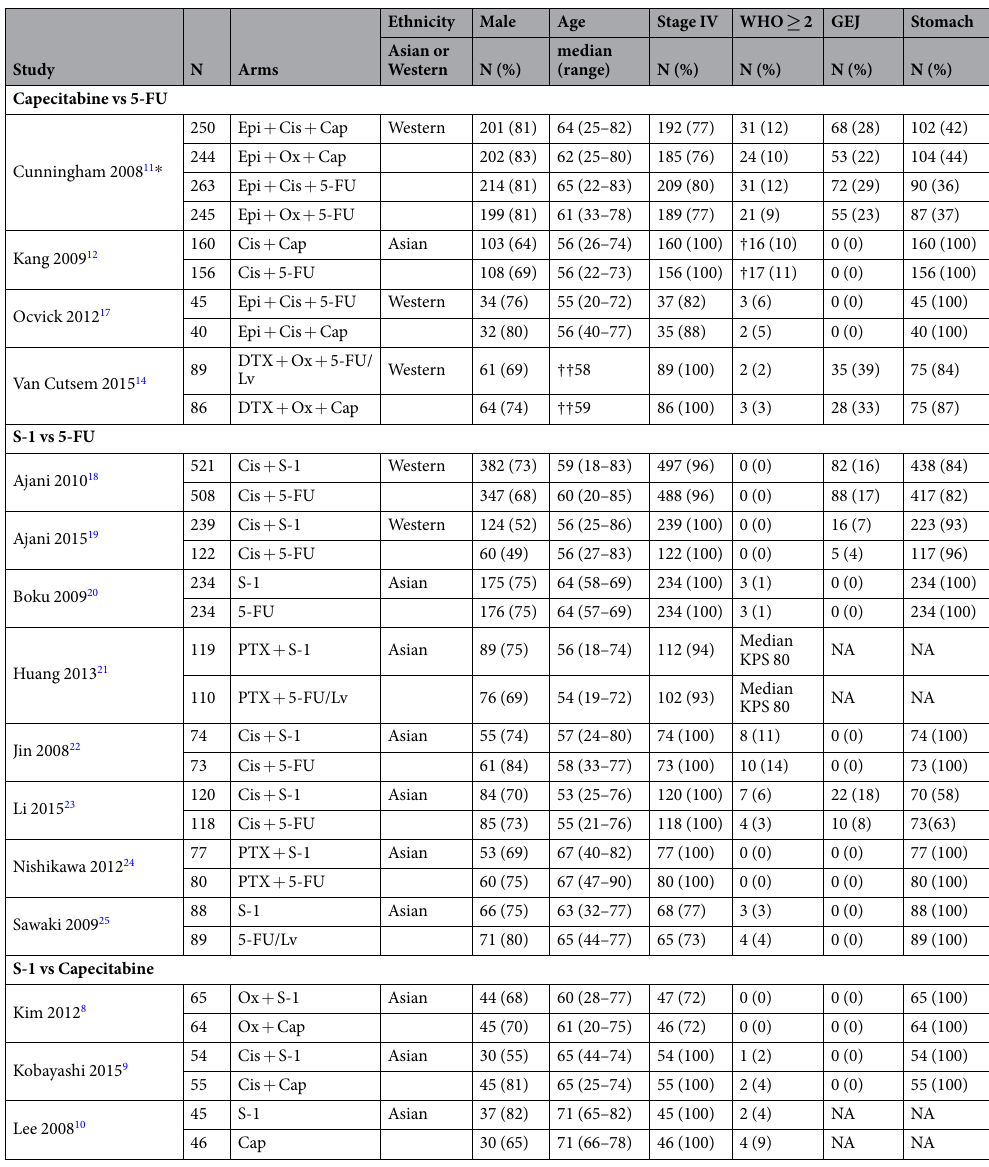
Table 1. Baseline characteristics. Abbreviations: 5-FU: 5-fluorouracil, Cap: capecitabine, Cis: cisplatin, DTX: docetaxel, Epi: Epirubicin, GEJ: gastro-esophageal junction, KPS: Karnofsky Performance Status, Lv: